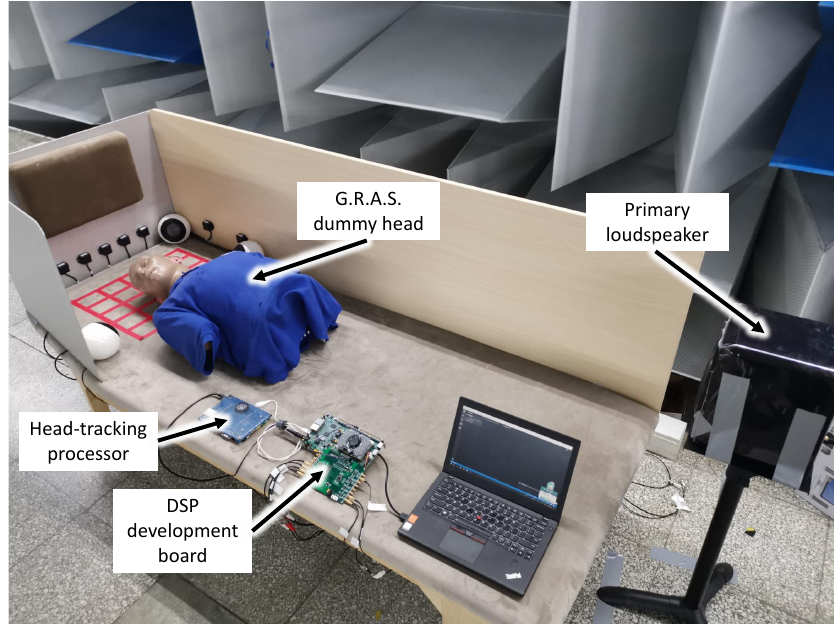
Figure 3. Photograph of experimental